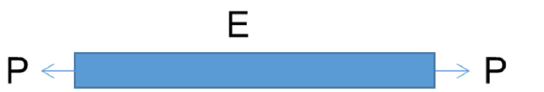
Figure 2. Simplified diagram of bonds between material points.